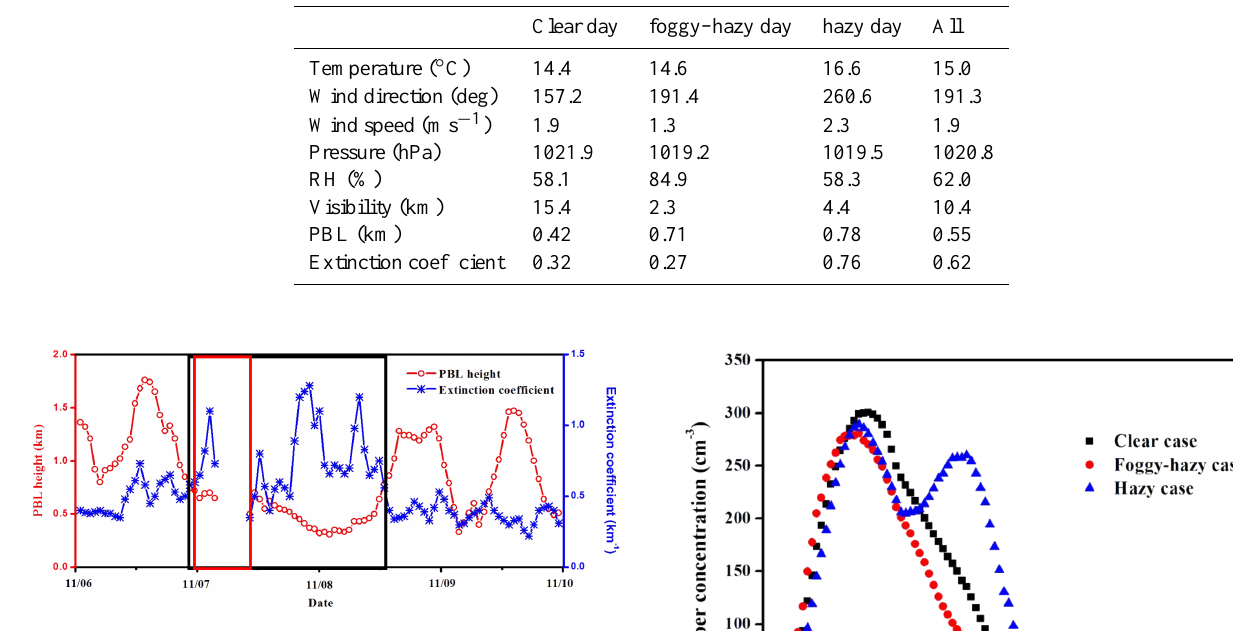
Figure 3. Temporal variations of PBL and vertical extinction coef- ficient (500m) measured by MPL lidar. Data from 05:00–09:00 on 7th are labeled as invalid and not shown. The foggy–hazy case is marked in red open boxes and the hazy case in black.